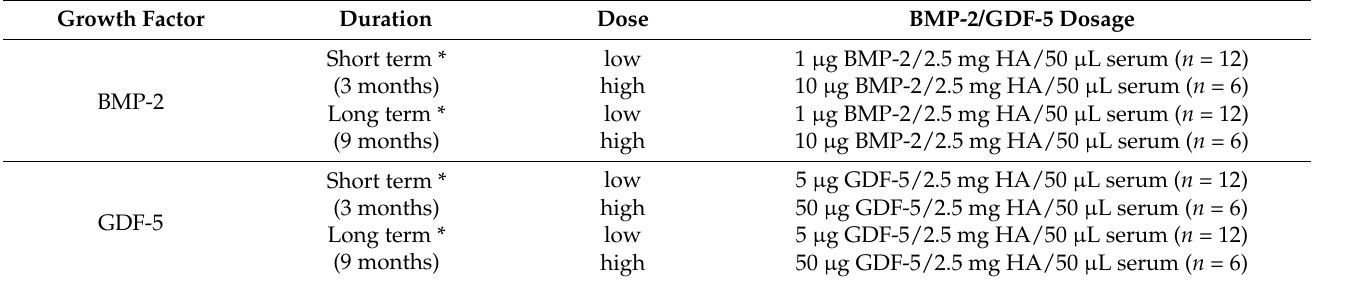
Table 1. Time schedule of the animal